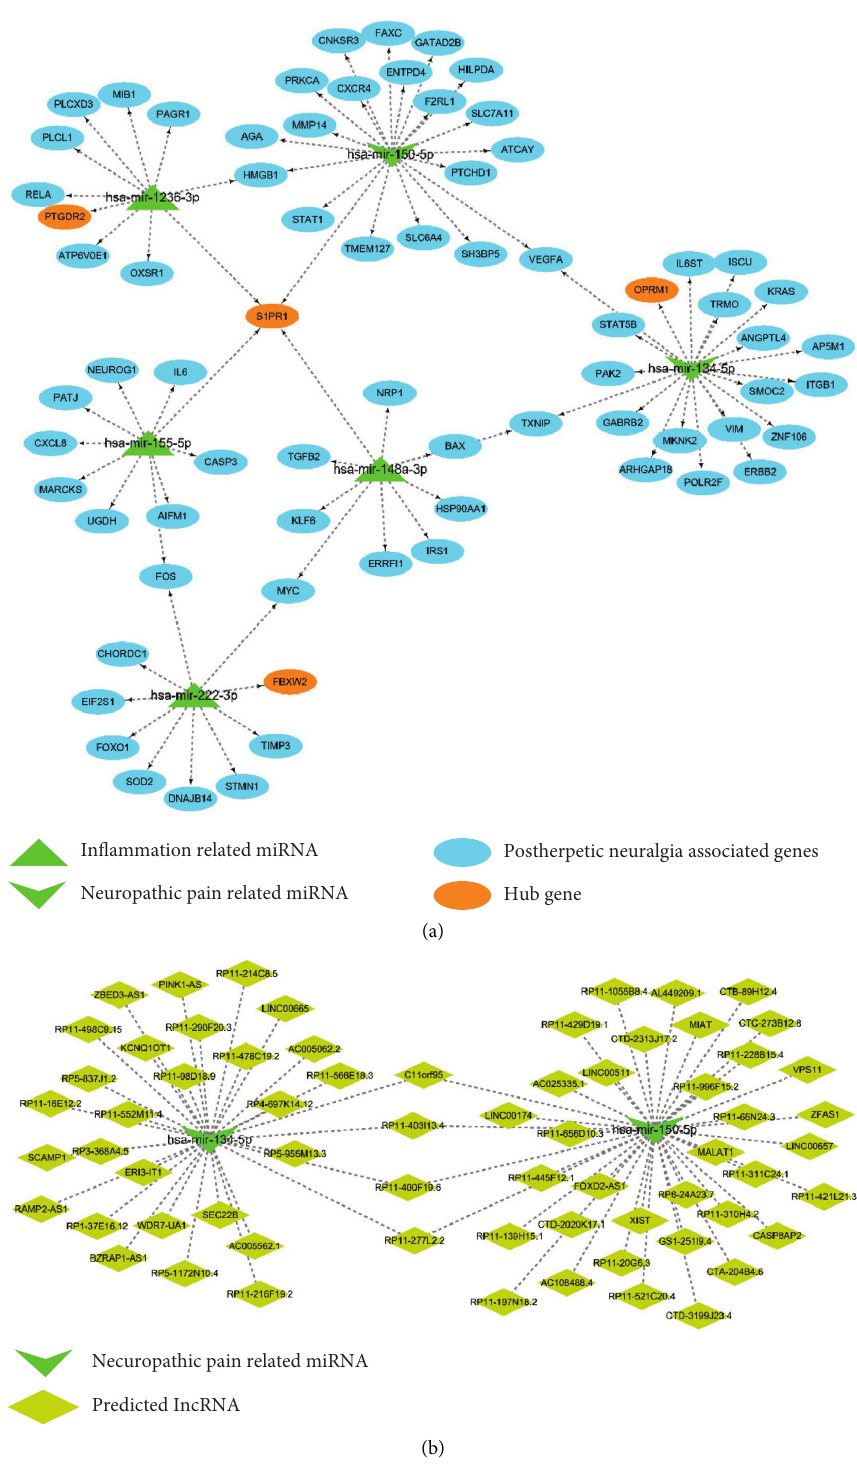
Figure 7: The miRNA-mRNA network and lncRNA-miRNA network. (a) miRNA-mRNA network. (b) lncRNA-miRNA network predicted by neuropathic pain-related miRNA hsa-mir-150-5p and